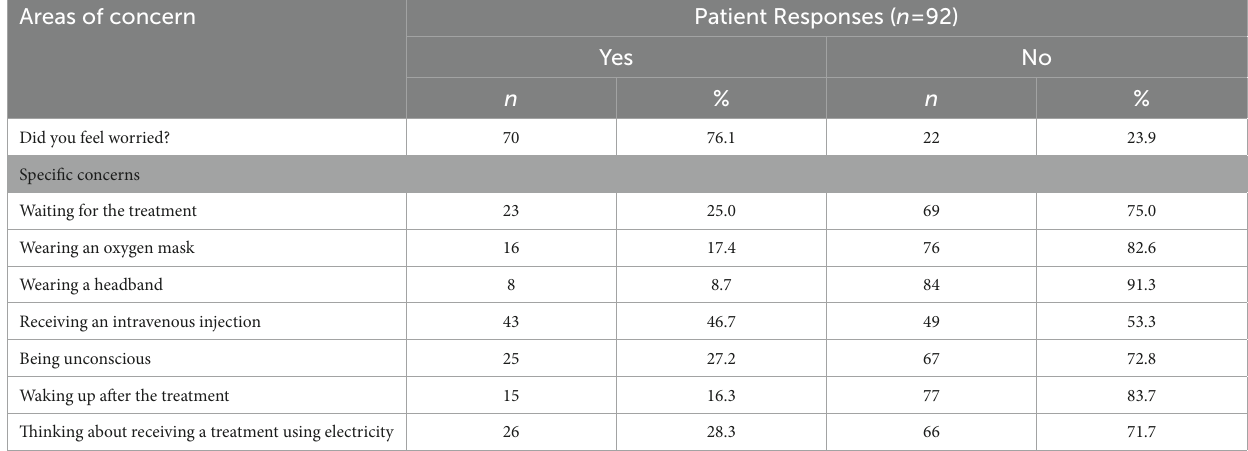
TABLE 4 Patient worries about receiving electroconvulsive therapy. Areas of concern